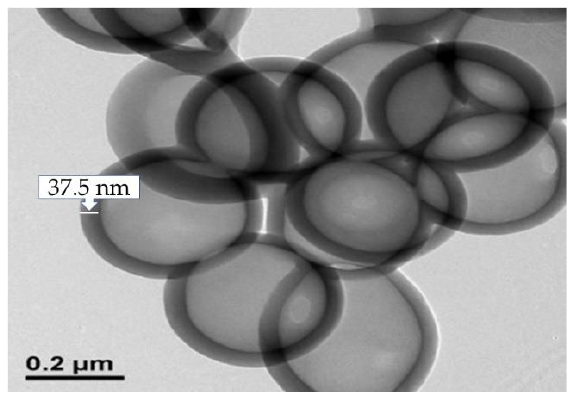
Figure 24. pH-Poly-(methacrylic acid) (PMAA)-sensitive nanocontainers.